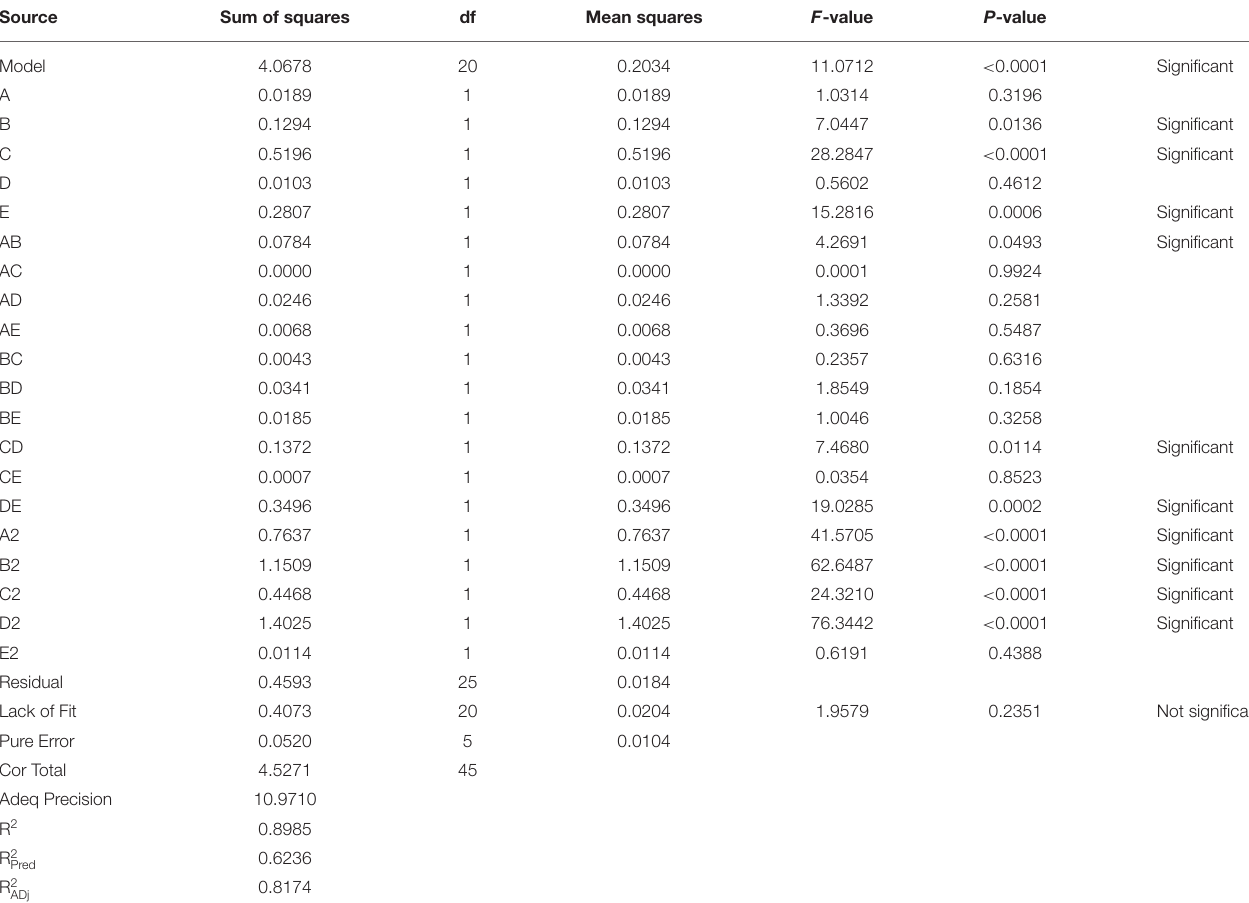
TABLE 2 | Regression coefficients estimate and significance test for the quadratic polynomial model.